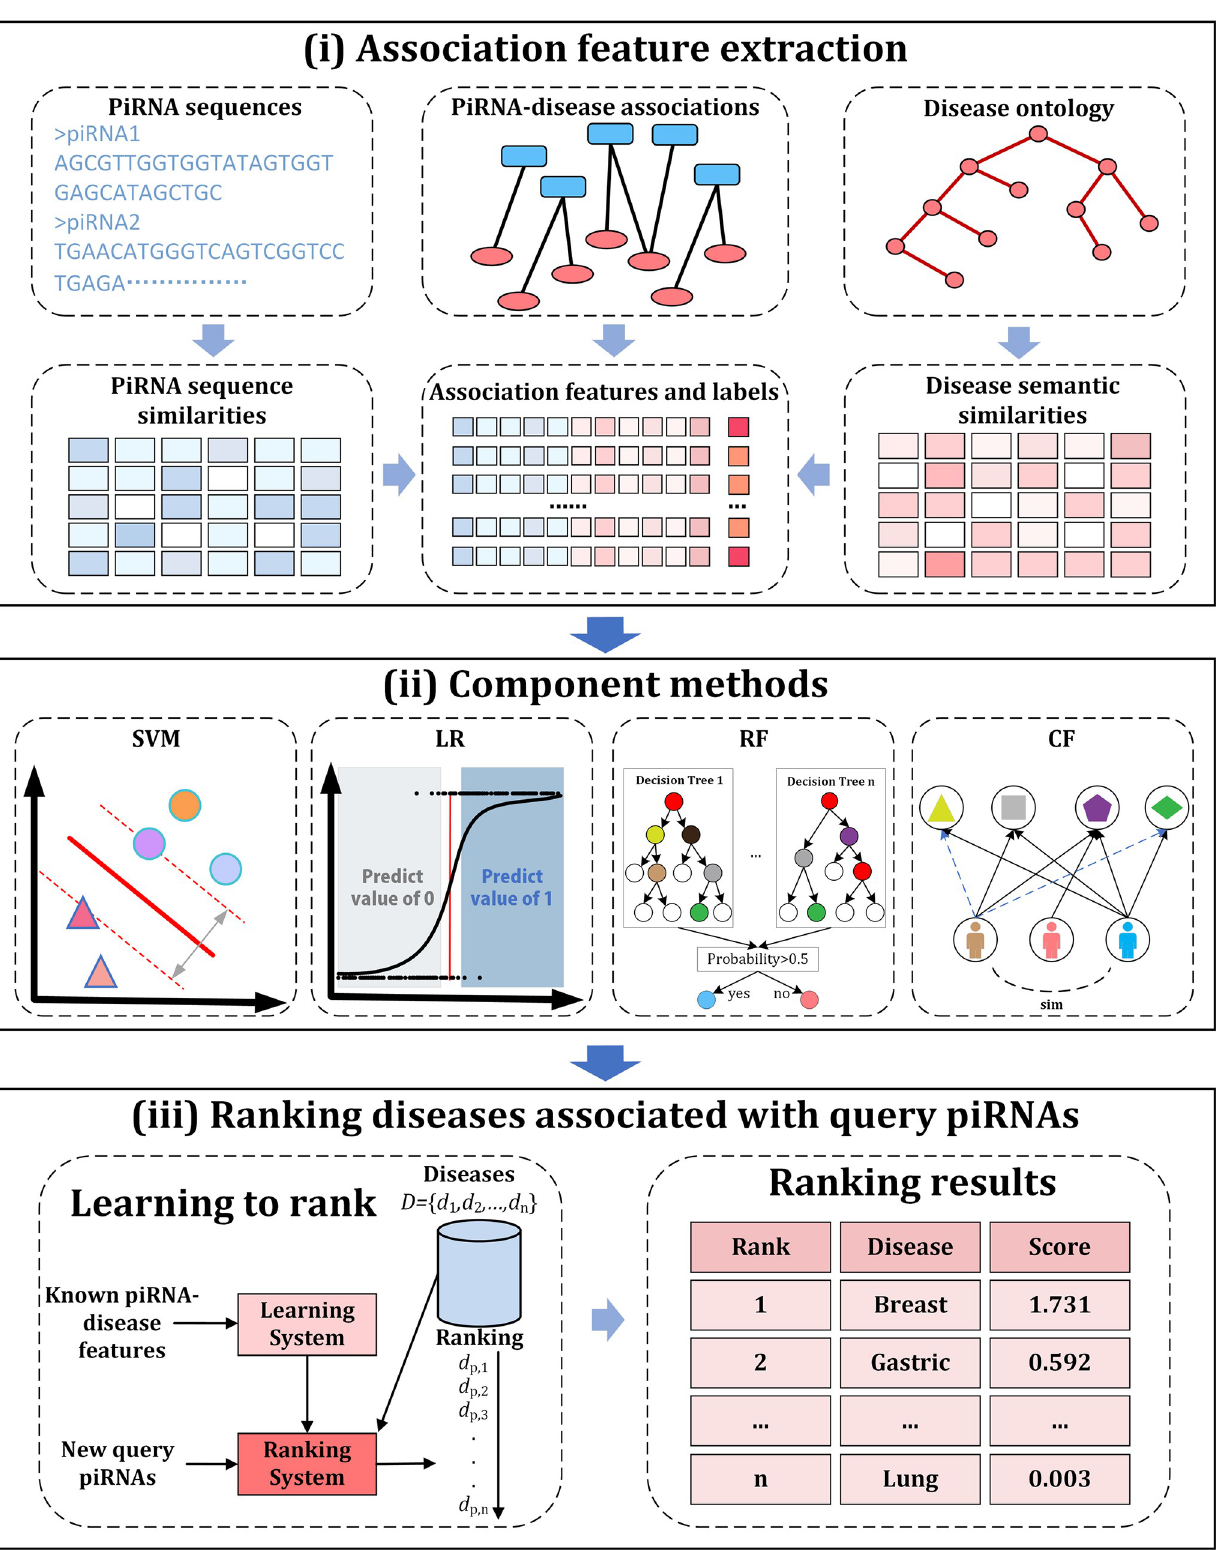
Fig 2. The workflow of iPiDA-LTR predictor. (i) Association feature extraction: piRNA sequences and disease ontology are used to calculate piRNA sequence similarities and disease semantic similarities by combining them and piRNA-disease associations to construct association features and labels; (ii) Component methods: four methods are used to train models with benchmark dataset, and then trained models are utilized to calculate association scores